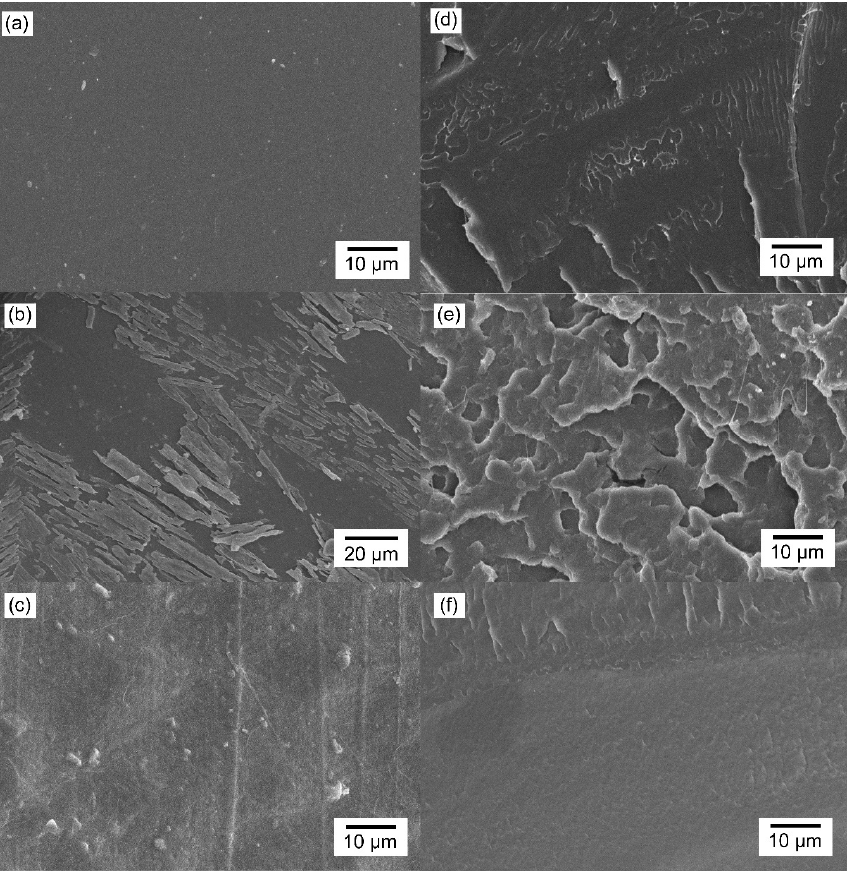
Figure 4. SEM images of ( a ) neat PLLA, ( b ) soaking-PLLA, and ( c ) scCO 2 -PLLA surfaces; and of ( d ) neat PLLA, ( e ) soaking-PLLA, and ( f ) scCO 2 -PLLA cross-sections.